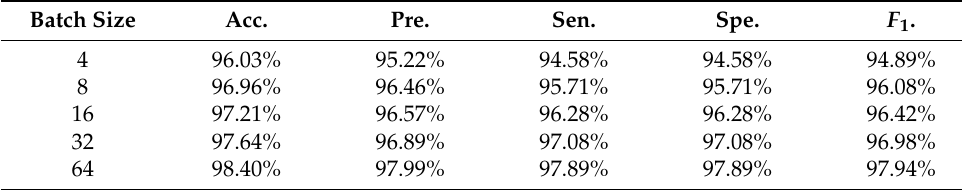
Table 12. Classification results of different batch sizes on the Coronahack dataset. Batch Size Acc. Pre. Sen. Spe. F 1